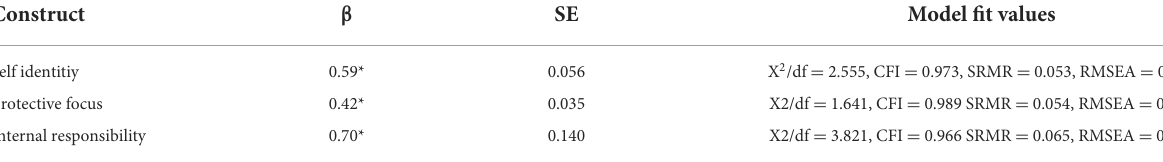
TABLE 7 Psychological ownership sub-dimensions path analaysis